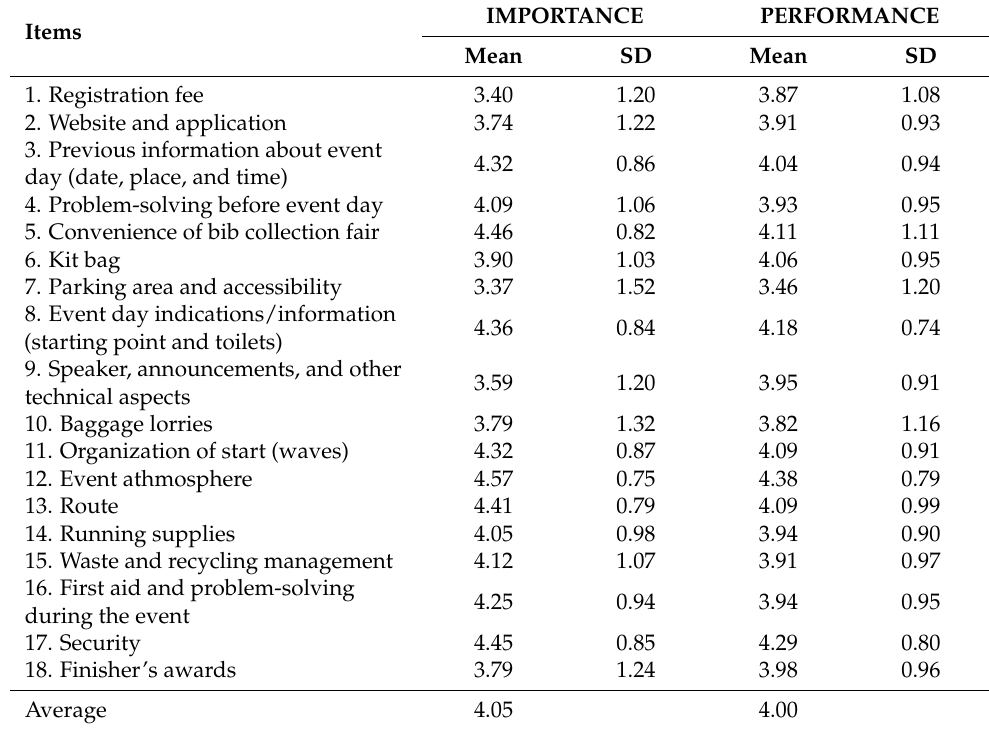
Table 2. Means and standard deviations (SDs) for the importance and satisfaction items as perceived by the participants (n =